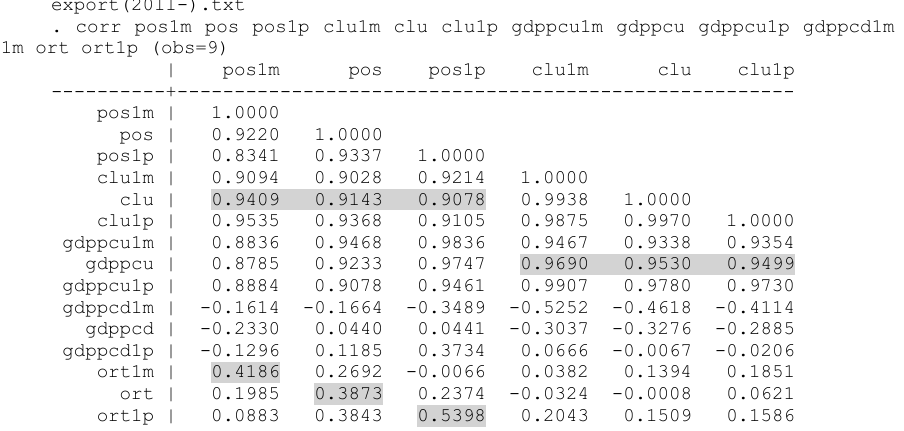
Figure 9. Cross-correlation matrix of parameters pos, clu, gdppcu, gdppcd, and ort with a 1-year shift for the period starting from